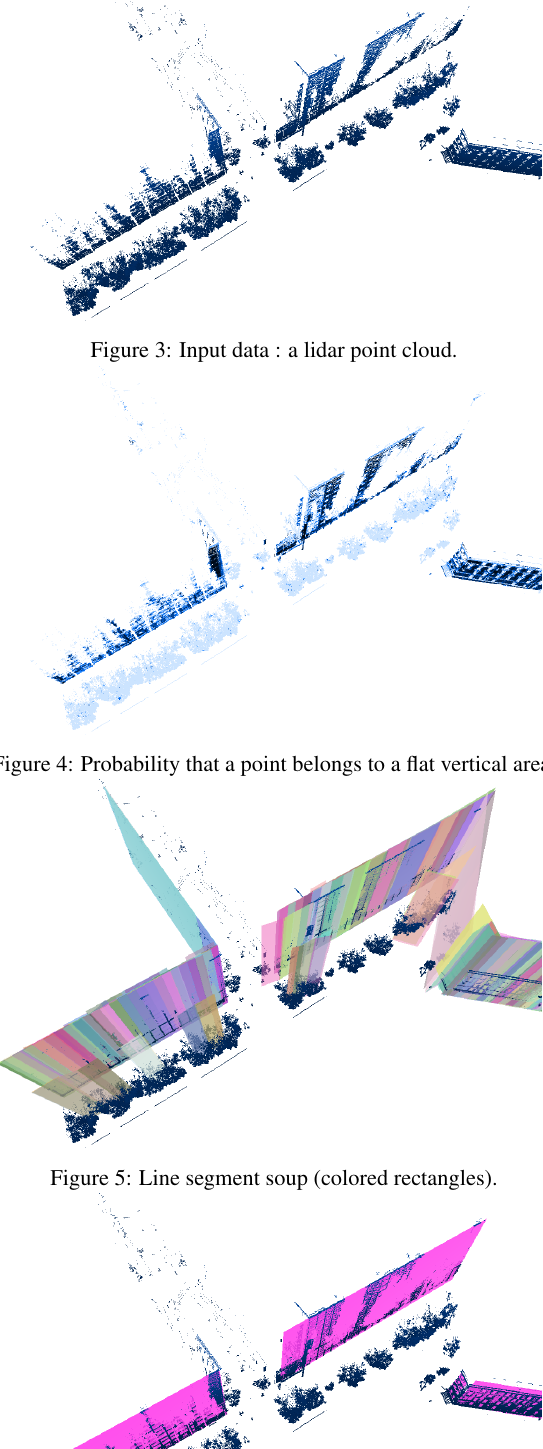
Figure 3: Input data : a lidar point cloud.